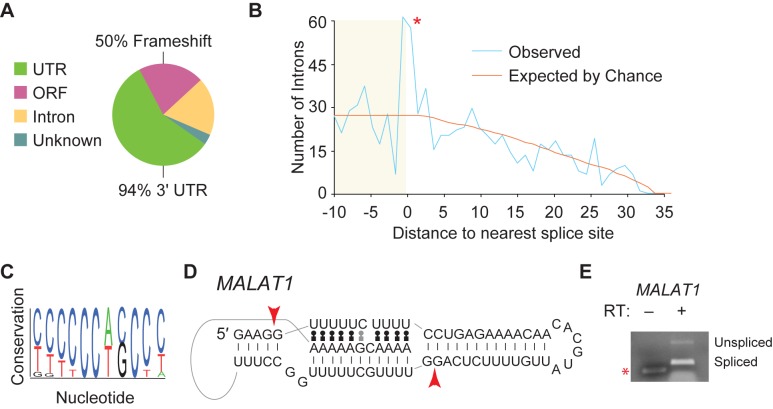
Non-canonical introns may include additional IRE1 targets, and lncRNAs can harbor short introns.(A) Non-canonical introns were analyzed as in Fig 5A. Here, however, the majority of introns were found in mRNA 3ˈ UTRs. Of those short introns that lay in ORFs, 50% are predicted to change the translational reading frame. (B) Short introns were screened for the IRE1 consensus sequence that has been identified from both XBP1 mRNA and RIDD targets [44]. Of the 861 mRNAs with the consensus sequence, we calculated the distance between the consensus sequence start and the exon/intron boundary (0 on the x-axis). There is a striking and significant (p < 0.01) peak at the exon/intron boundary indicating that many of these introns were processed at an IRE1 consensus sequence. (C) MEME analysis was done for the non-canonical introns, and one significant (p < 0.01) motif was returned (shown). The motif is very cytidine-rich. (D) One of the four short introns from the MALAT1 lncRNA is shown. The splice sites (arrowheads) are located proximal to gaps in secondary structure. Note that intron excision removes sequences that are capable of forming a triple helix in MALAT1. (E) We used RT-PCR to confirm short intron removal from MALAT1 lncRNA. Primers were designed to detect both pre-mRNA as well as spliced mRNA. As predicted from our splicing efficiency analysis, the short intron was alternatively spliced, although the spliced form predominates. The sample that omitted reverse transcriptase (from the RT step) serves as a control for contaminating DNA with a shorter product observed (*).